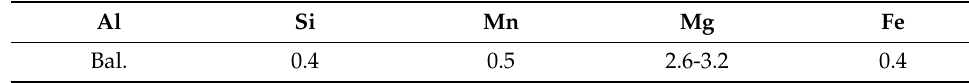
Table 1. Chemical composition of AA5754.